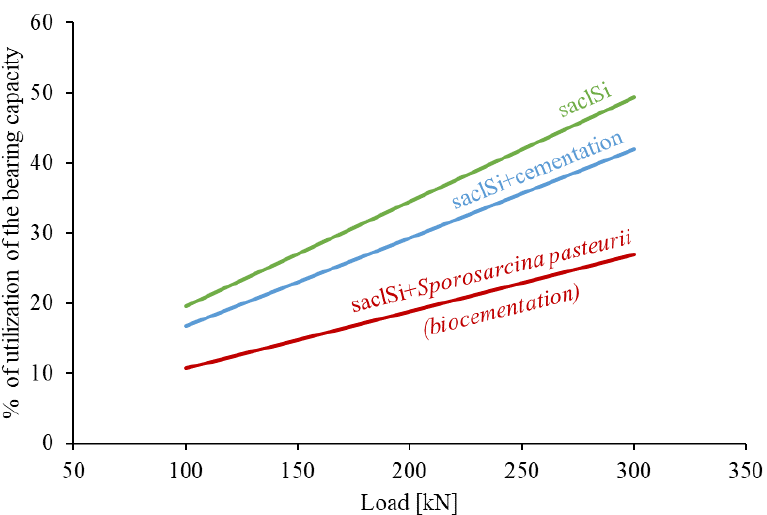
Figure 12. Percentage of utilization of vertical bearing capacity at different values of subsoil loads.